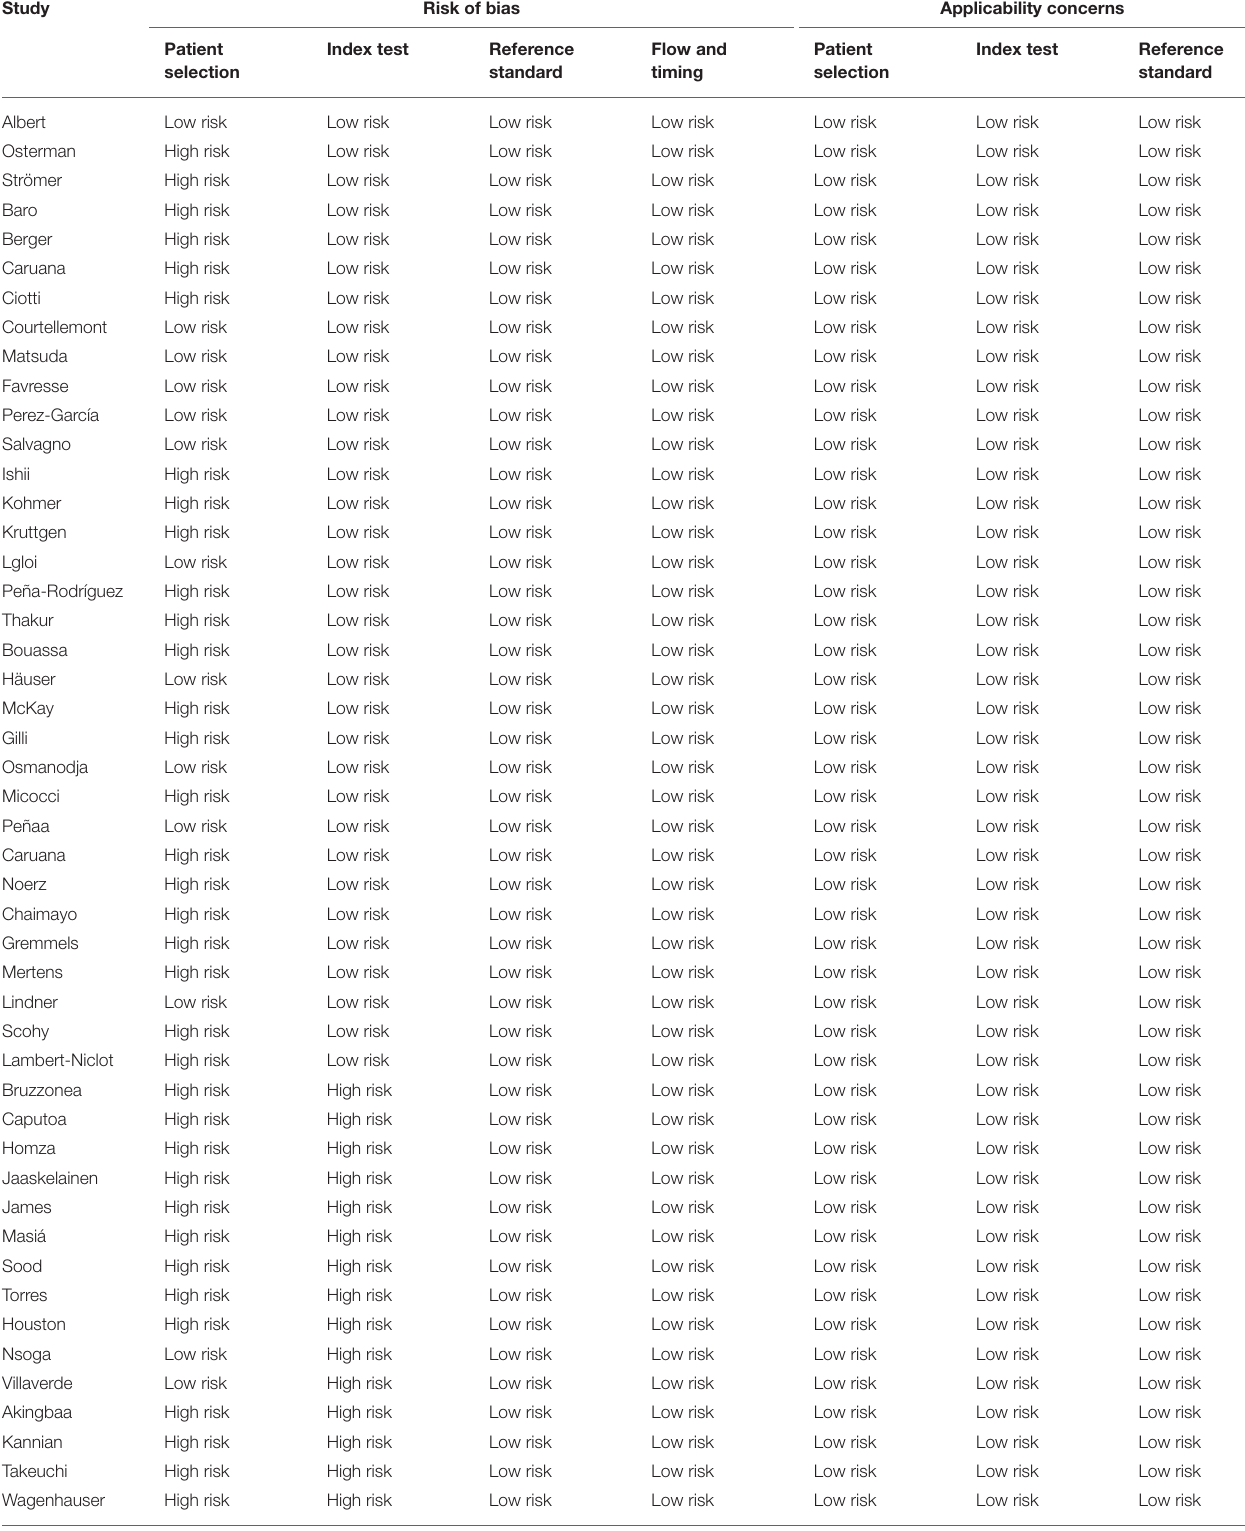
TABLE 2 | Quality assessment of included